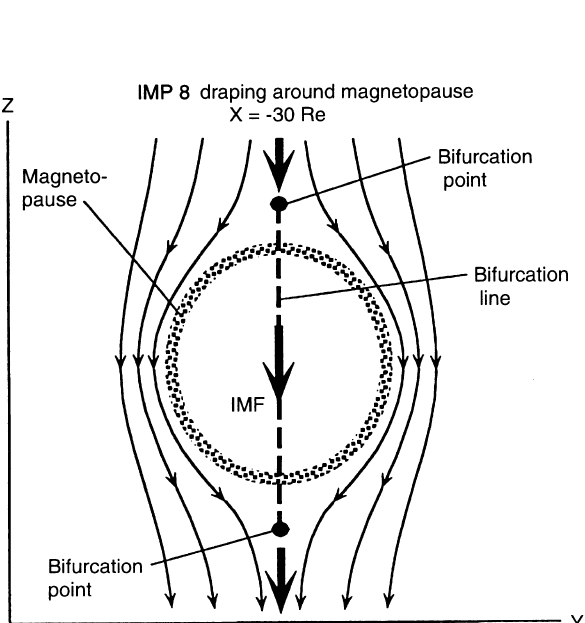
indicate that the di(cid:128)erences between the MHD model vectors and IMP 8 magnetic field observations are smaller close to the magnetopause where the GD model di(cid:128)ers most. Qualitatively, both models produce a similar cross-sectional field geometry of the draped